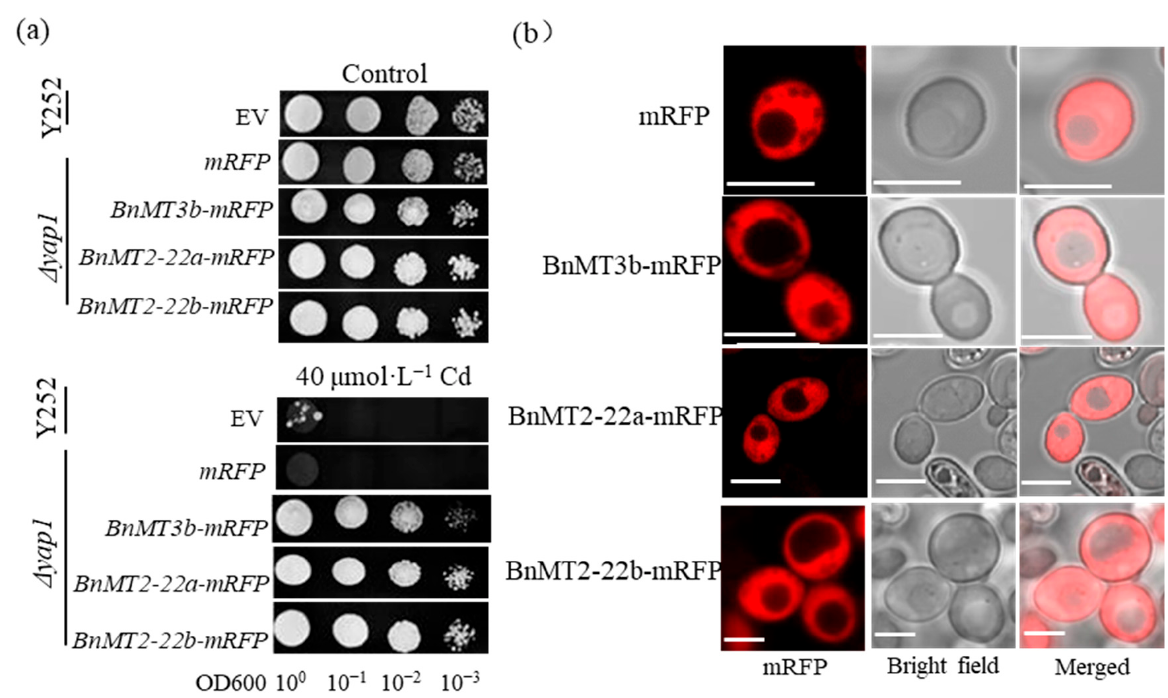
Figure 4. BnMTs were localized to the cytosol. ( a ) The BnMTs-mRFP fusion protein is functional in yeast. ( b ) Subcellular location of BnMTs-mRFP in yeast culture in liquid SD medium without Cd. Bar = 5 μ m. EV: empty vector.